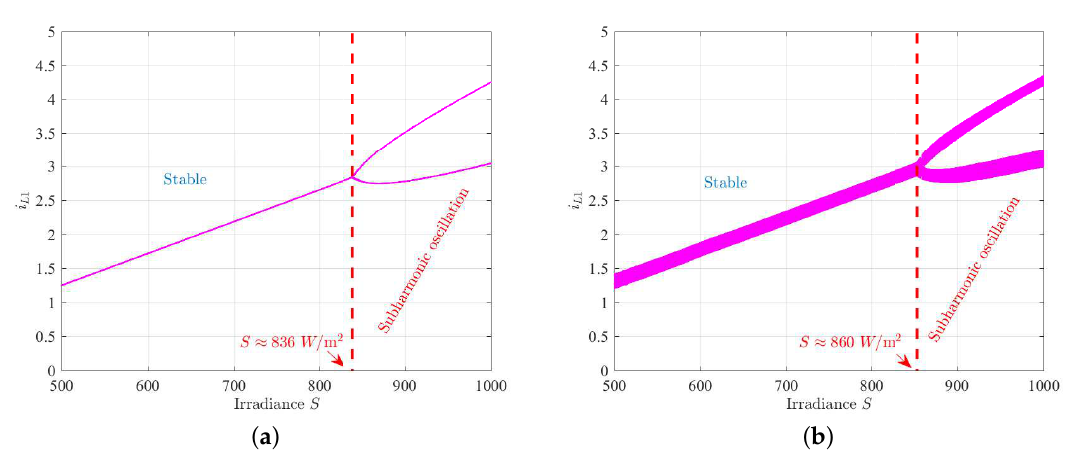
Figure 11. The bifurcation diagram of the quadratic boost regulator with a nonlinear PV source under extremum seeking MPPT control for regulating the input voltage taking the irradiance S as a bifurcation parameter. ( a ) With the exact theoretical conductance g ∗ and ( b ) with the conductance G mpp provided by the extremum seeking MPPT. V M = 4 V. Θ = 25 ◦